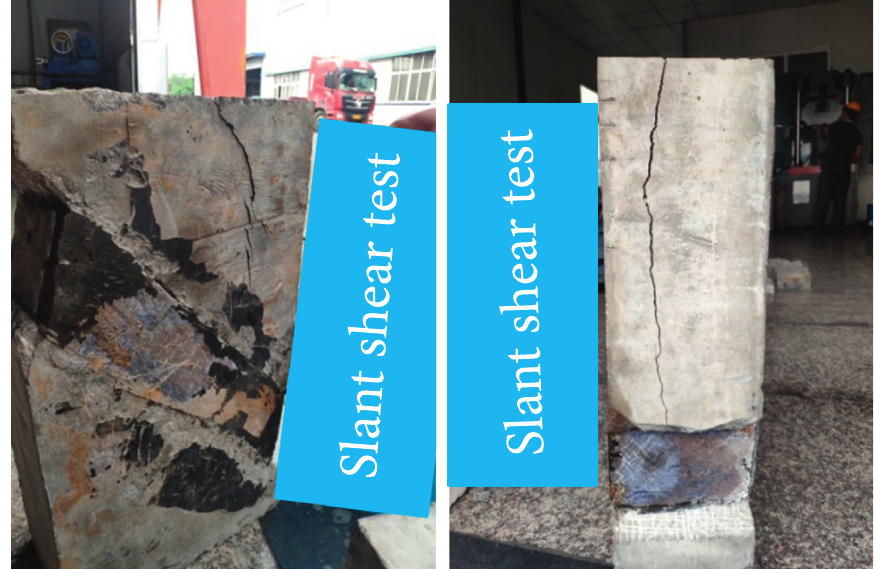
Figure 11: The failure mode of slant shear test specimen 3. Table 6: Friction coefficient under different stress